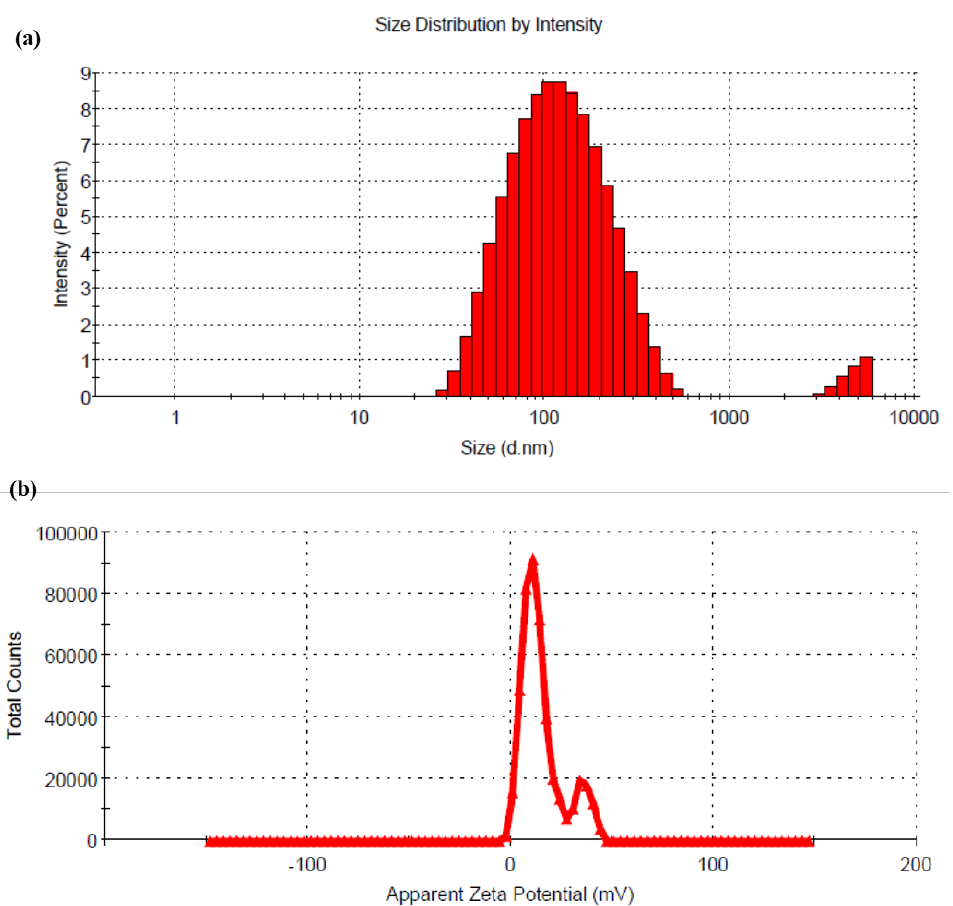
Figure 2. ( a ) Hydrodynamic diameter of optimized RTG-LCNP based on the % intensity; ( b ) zeta potential of optimized RTG-LCNP.